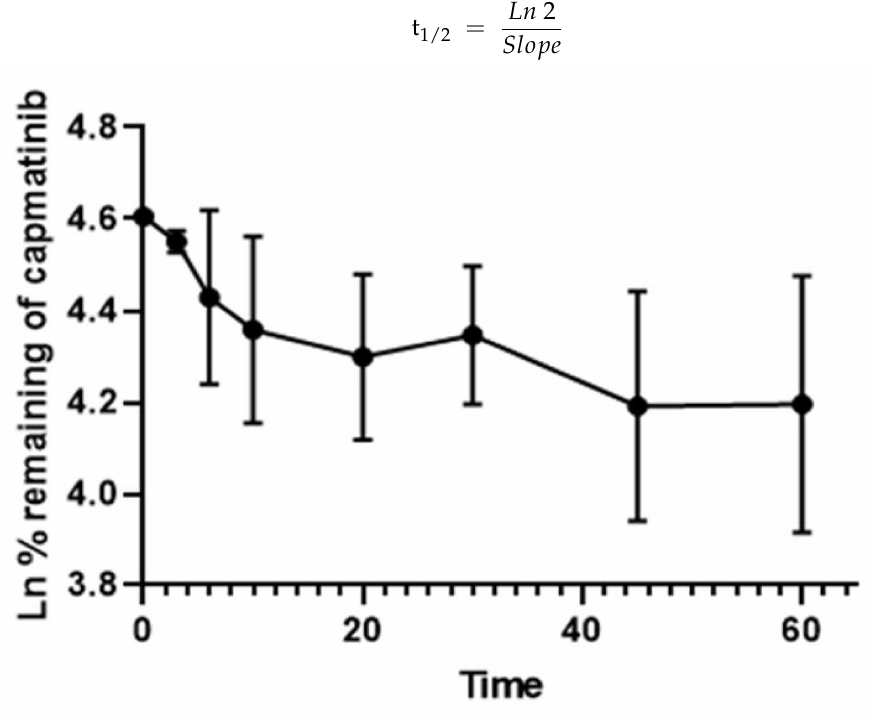
Figure 6. Capmatinib depletion rate when incubated with 0.3 mg/mL HLMs. The data are shown in mean ±